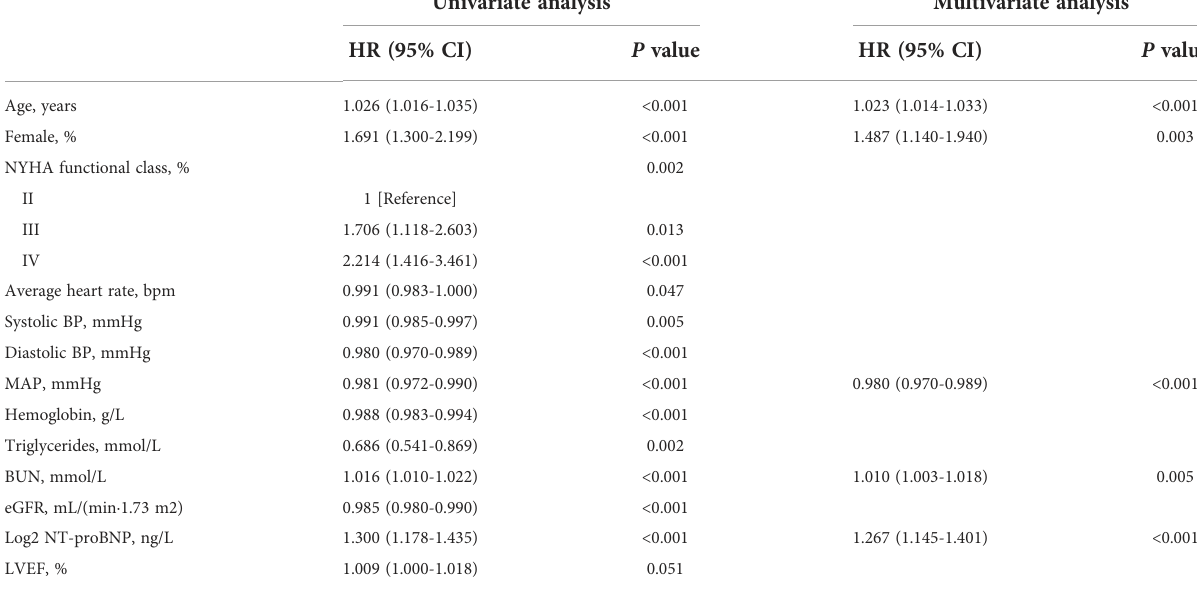
TABLE 3 Univariate and multivariate stepwise Cox regression analysis of all-cause mortality in patients with AHF. Univariate analysis Multivariate